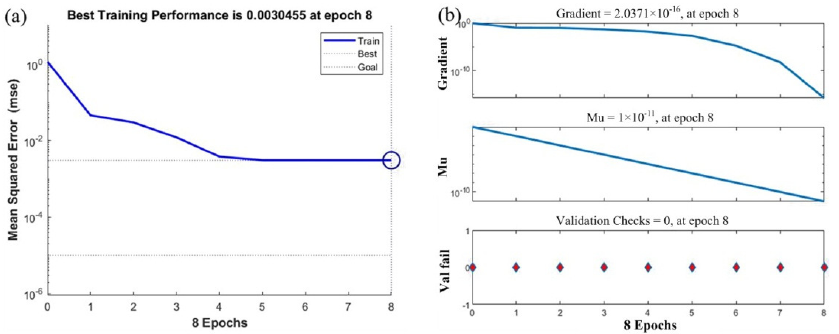
Figure 10. BP neural network: ( a ) mean square error and ( b ) gradient descent algorithm parame- ters.